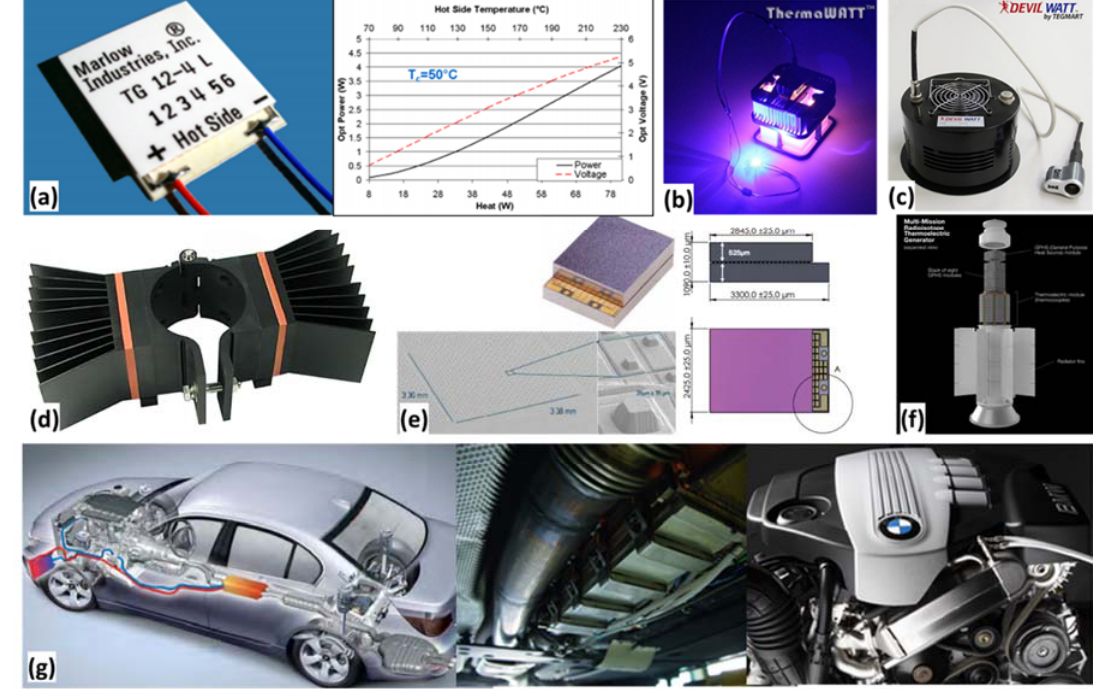
Figure 10. Example commercial thermoelectric generators (TEGs) and their applications. ( a ) TG12-4 TEG from Marlow Industries, Inc. [90]. This TEG of dimension 30 mm × 30 mm generates 4.0 W electrical power across temperature difference of ~180 °C; ( b ) ThermaWatt, a candle powered TEG converts the heat of a candle into electricity [91]. A ThermaWatt of size: 89 mm × 95 mm × 95 mm has power output of 500–800 mW near room temperature; ( c ) DW- DF-10W Camp Stove TEG. This TEG can be placed on top of an open flame source such as a propane stove to charge a battery, power a 12 V DC device, or charge a cell phone [92]; ( d ) EverGen PowerStrap, a product of Marlow Industries, Inc., is used to harvest thermal energy from fluid filled pipes or exhaust stacks for Industrial and Oil/Gas applications [93]; ( e ) MPG- D655 Micropelt thermogenerator chip [94] is a thin film thermoelectric generator having